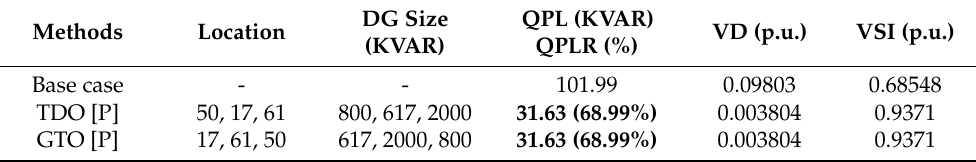
Table A5. Results of OADG for a 69-bus RDN for QPL minimization at unity pf (PV Type) in a CP load model.